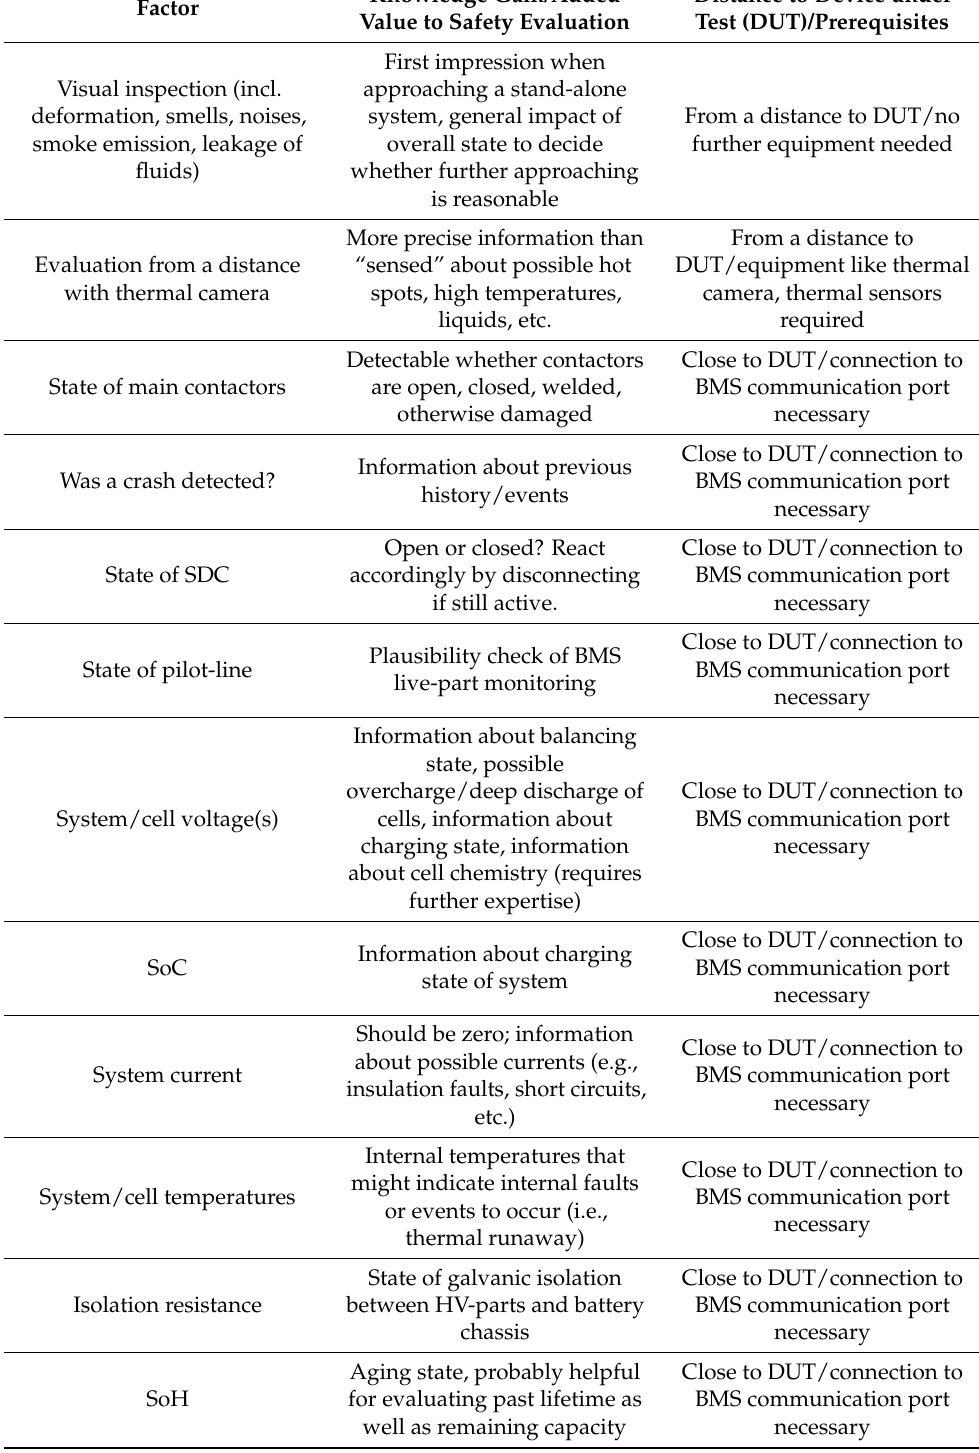
Table 1. Excerpt of factors/information to consider when assessing the safety state of a battery.